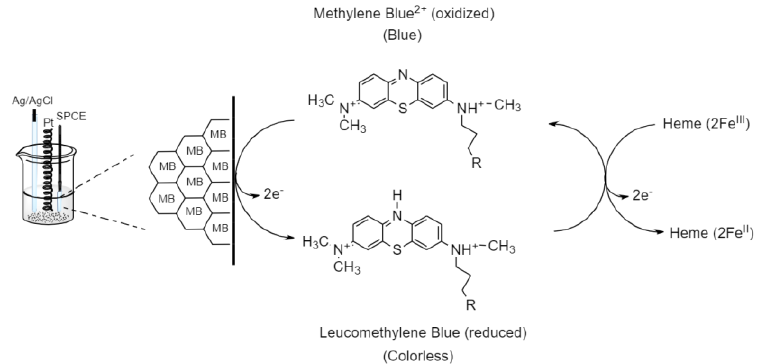
Figure 12. Electrocatalytic reduction of hemeproteins at MB / GP modified electrode .